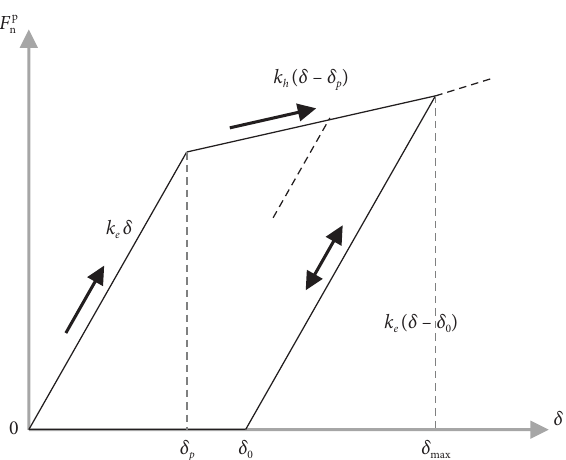
Figure 11: Elastoplastic force-displacement law in the normal